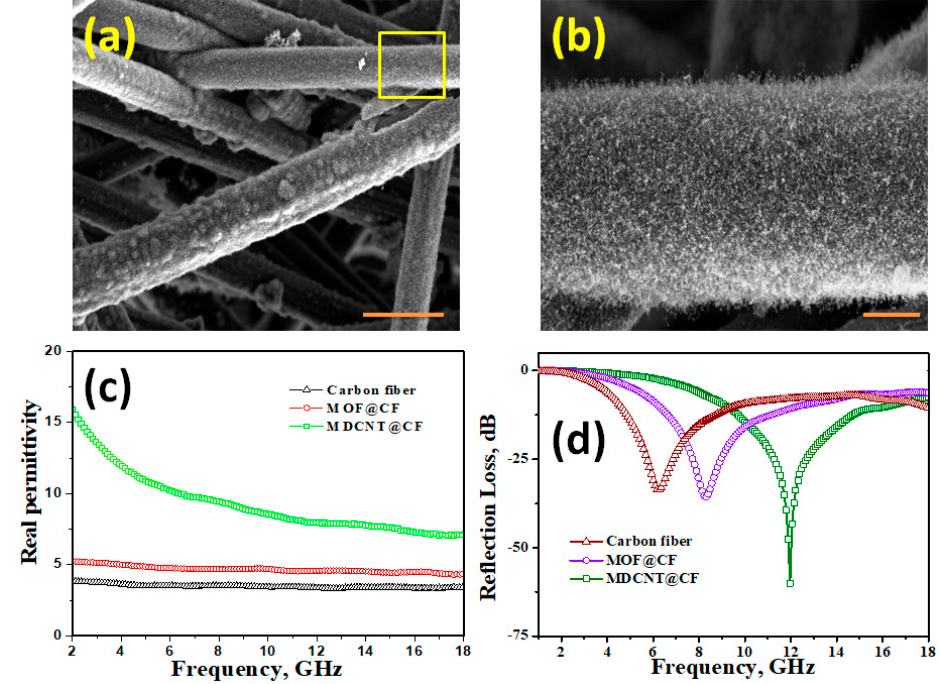
Figure 5. Representative SEM micrographs of MOF-derived CNT grown on carbon fiber (MDCNT@CF) ( a ). High-resolution image of highlighted portion ( b ), variation in real permittivity ( c ) and reflection loss ( d ) in electro-magnetic range. Scale bars in ( a , b ) are 3µm and 1µm, respectively.